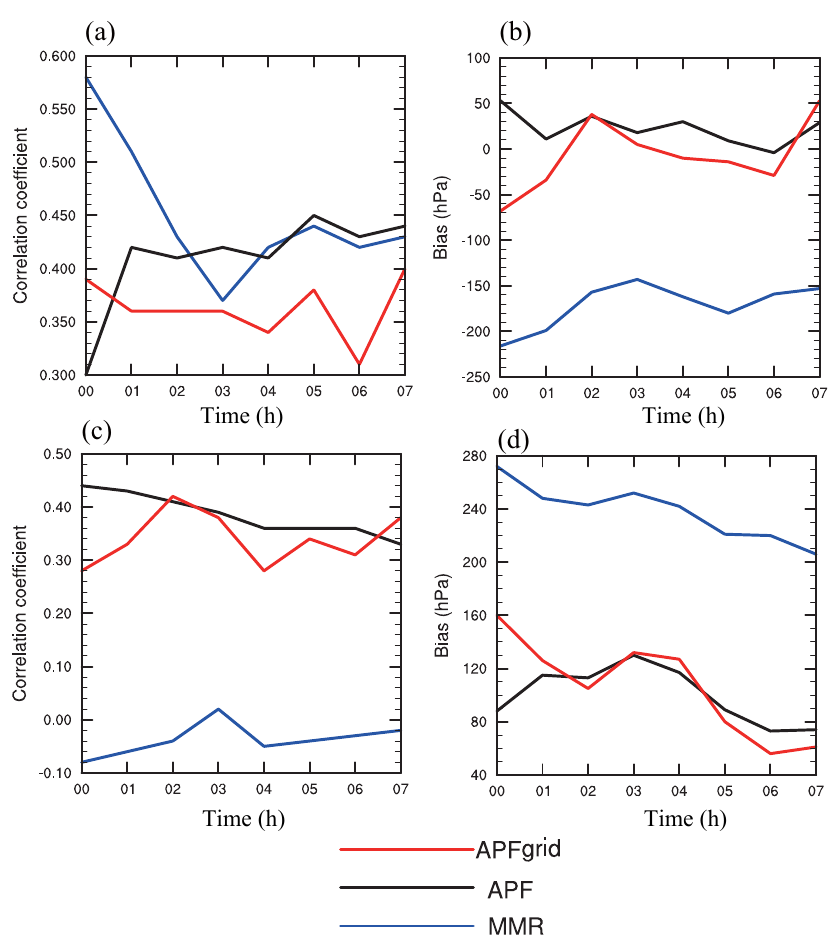
Figure 11. (a) Correlation coefficient, (b) bias for the cloud top pressure, (c) correlation coefficient and (d) bias for the cloud bottom pressure vs. the NASA GOES retrievals from 00:00 to 07:00UTC, 15 December